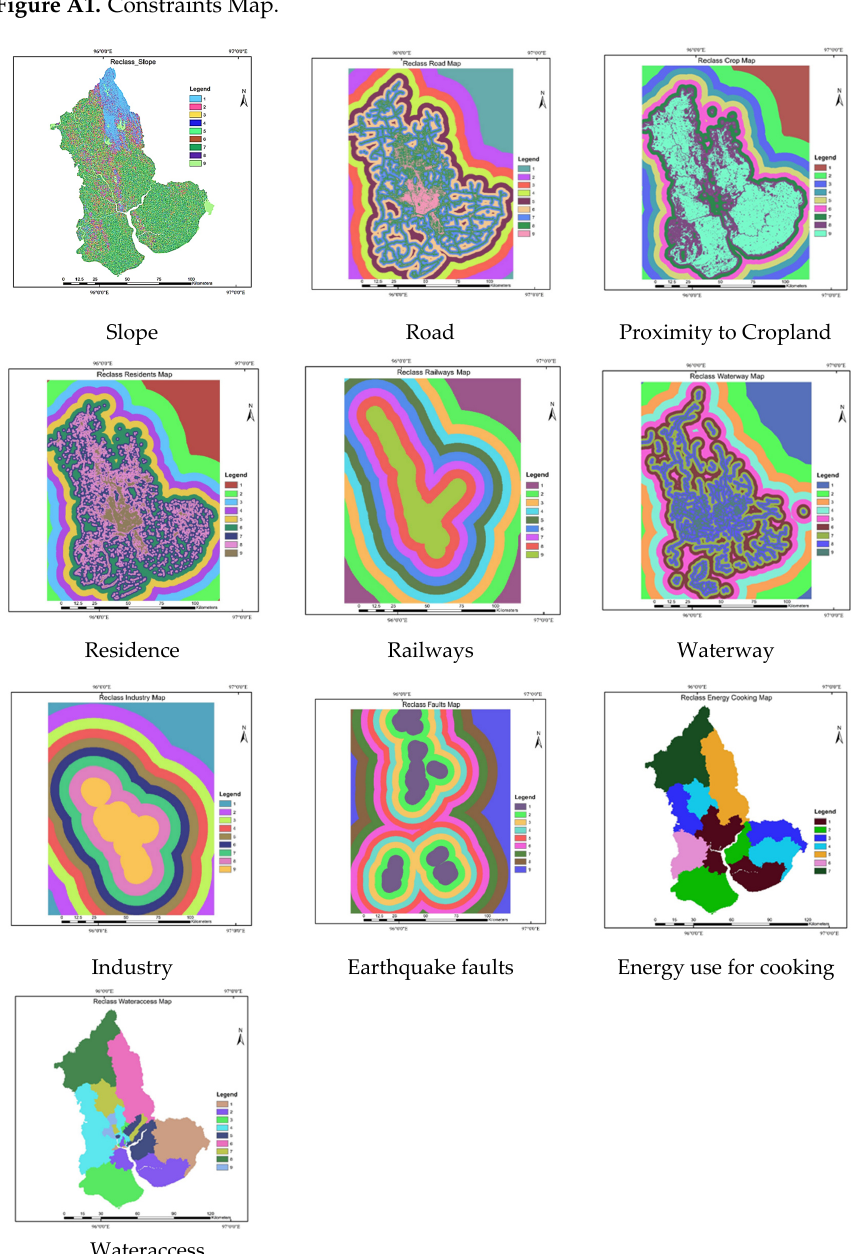
Figure A2. Reclassification of Factor Maps.